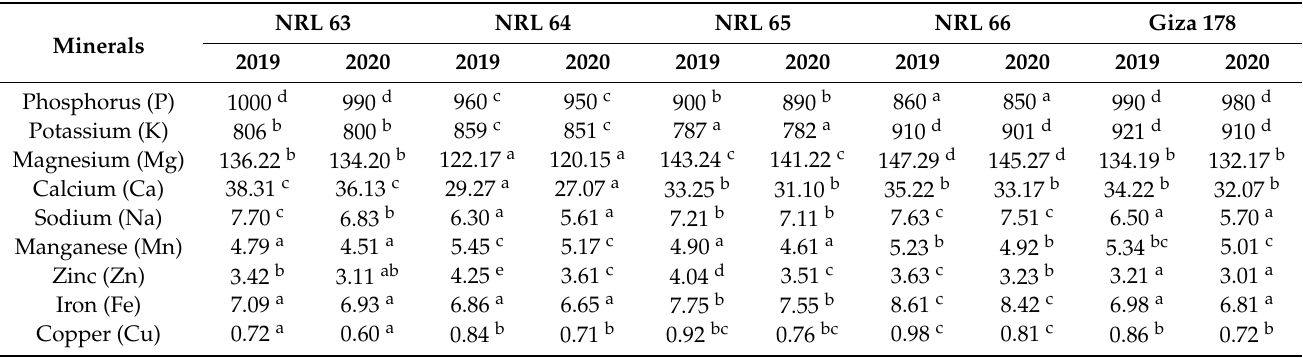
Table 5. Mean performances for minerals content (mg/100 g) of stabilized rice bran samples of the studied genotypes during the 2019 and 2020 growing